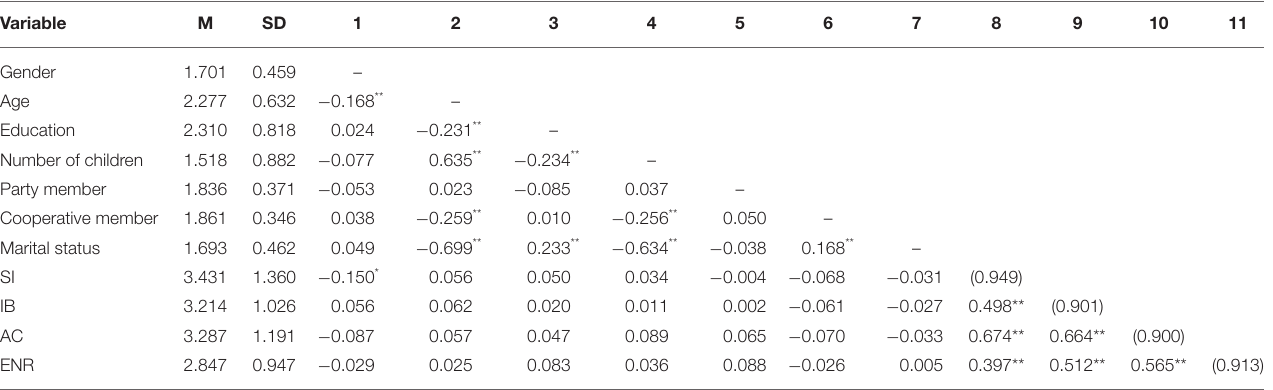
TABLE 2 | Descriptive statistics and correlation analysis ( N = 203).